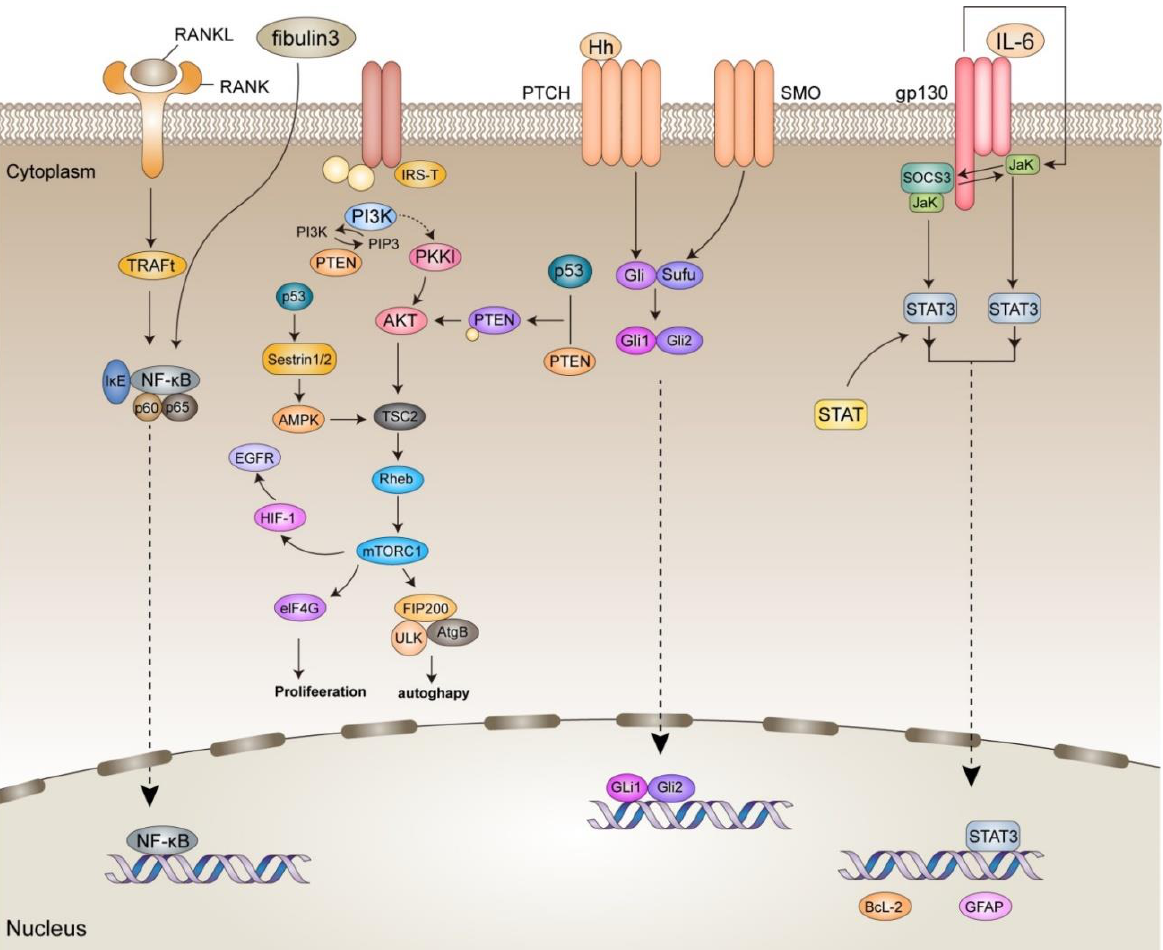
Figure 4. There are multiple signaling pathways in the glioma microenvironment that interact to influence the development of glioma. NF- κB is activated by upstream factors and then enters the nucleus to participate in the regulation of DNA synthesis in tumor cells. Aberrant activation of STAT has been shown to contribute to glioma proliferation, while IL-6 activates STAT3 via JAK. Akt